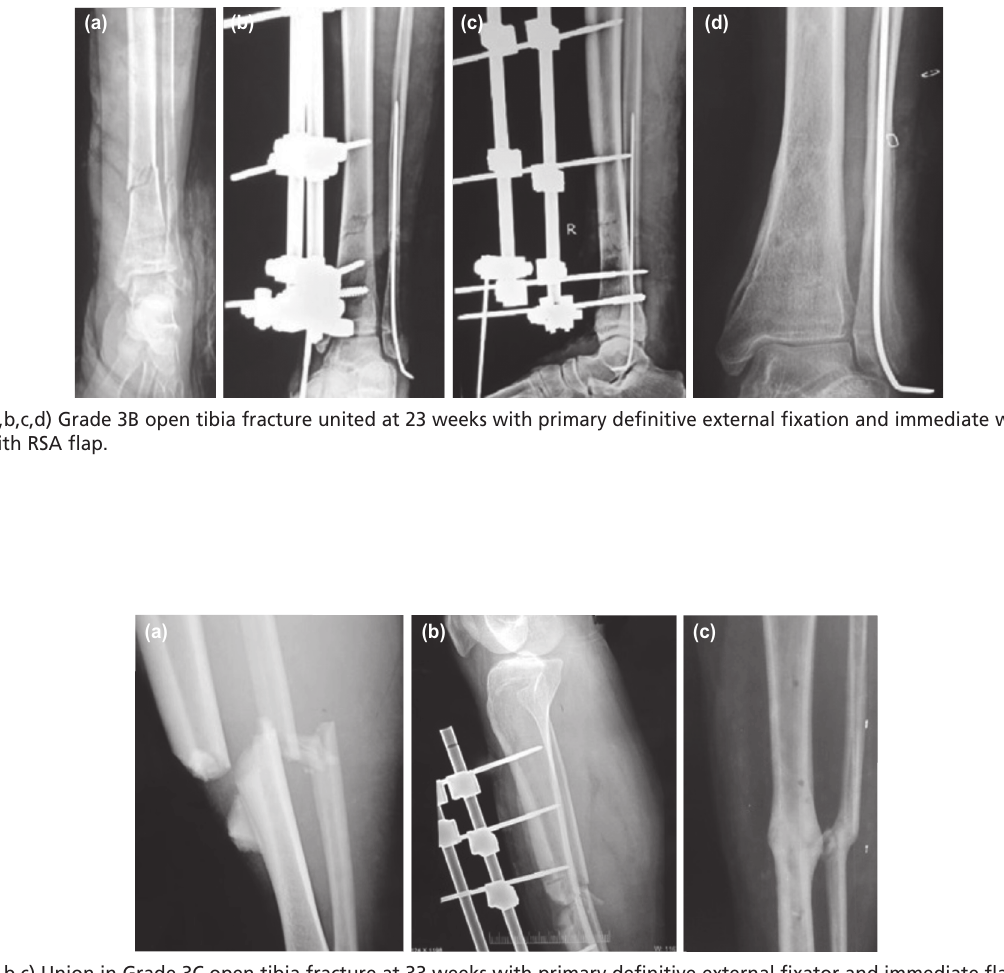
(a,b,c) Union in Grade 3C open tibia fracture at 33 weeks with primary definitive external fixator and immediate flap Fig. 8: